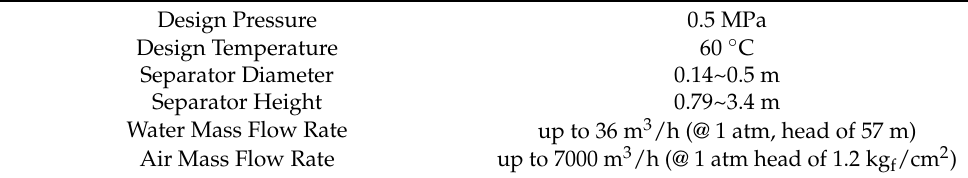
Figure 1. Schematic view and picture of the PEMS facility [8]. Table 1. Design specifications of the PEMS test facility.